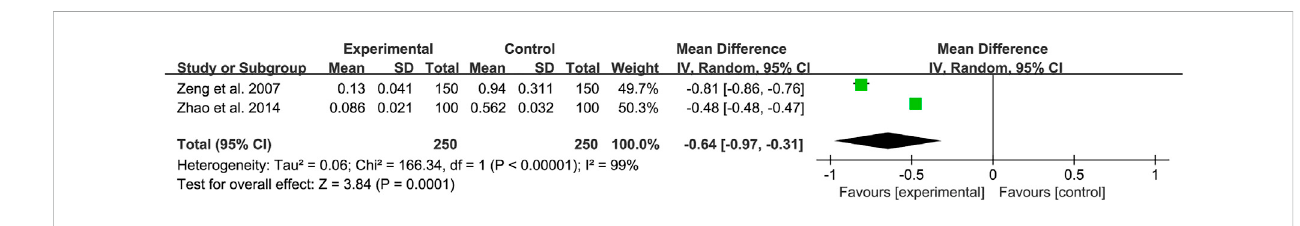
FIGURE 5 Forest map of proliferation number of tumor cells.